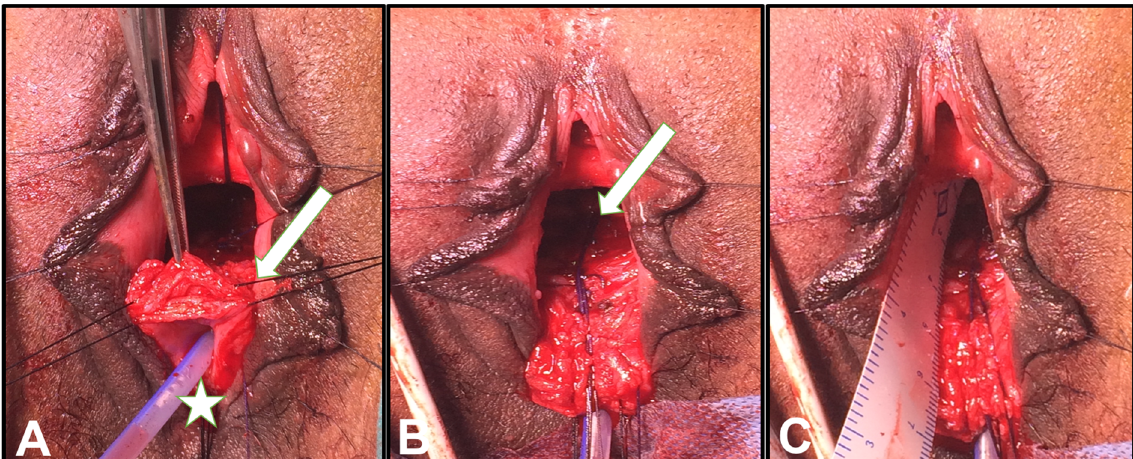
Figure 1. Intraoperative photographs during the Single-stage Trans-vestibular And Foley’s-assisted Epispadias Repair (STAFER): ( A ) The urethra was mobilized taking the retraction sutures on the periurethral soft tissue to minimize handling of the urethral meatus (solid arrow). During the entire procedure, Foley’s catheter was kept in situ and a constant traction was provided by the urethral catheter (marked as star); ( B ) After mobilization, tubularization of the urethra was started. The first stitch was taken proximal to the bulb of the urethral catheter (solid arrow); ( C ) Urethral lengthening can be appreciated at the end of the STAFER procedure. The average length of the tubularized urethra was 4.9